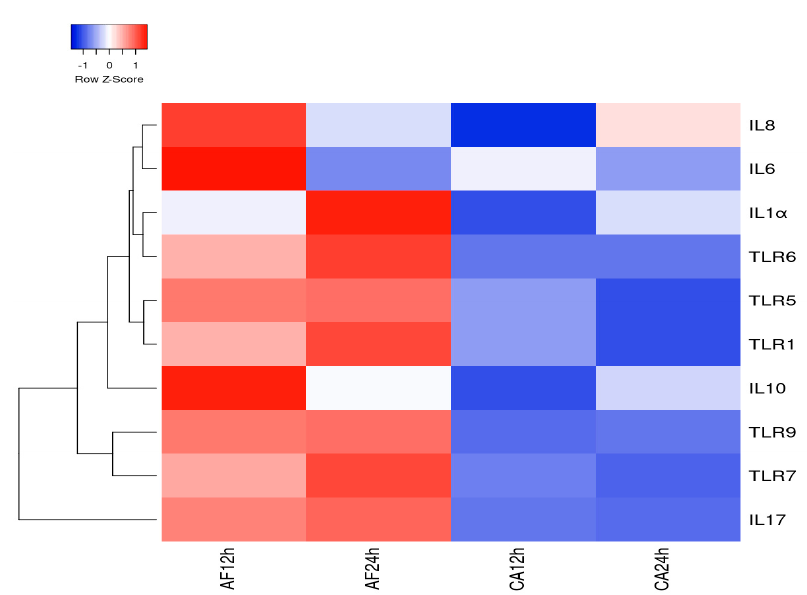
Figure 6. Gene expression heatmap constructed employing heatmapper.ca for 10 differentially expressed genes in human microglial cells challenged with A. flavus (AF) and C. albicans (CA) at 12 and 24 h p.i. The cluster value is coded with a range of colors from blue (for the lowest expression level) to red (for the highest expression level).